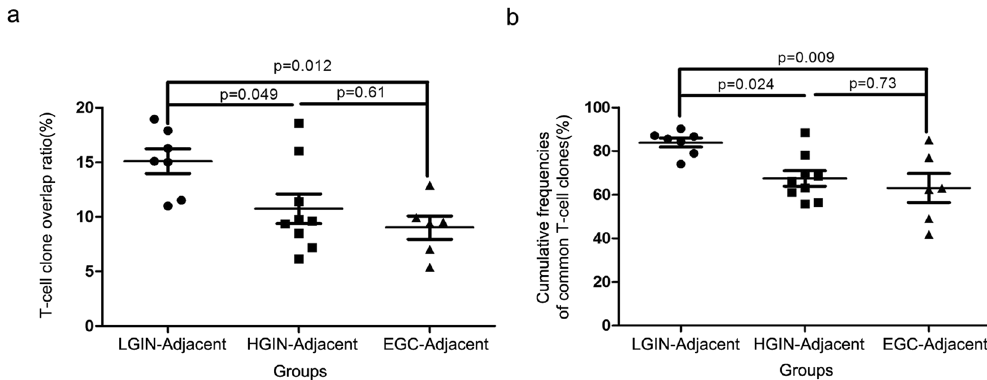
Figure 2. Comparison of the TCR repertoire overlap between gastric lesions and corresponding adjacent tissues. The T-cell clone overlap ratio ( a ) and the cumulative frequencies of common T-cell clones ( b ) between LGIN and adjacent tissues were significantly higher than HGIN-adjacent mucosa pairs and EGC-adjacent mucosa pairs. One-way ANOVA and Tukey’s post hoc multiple comparison test, p <